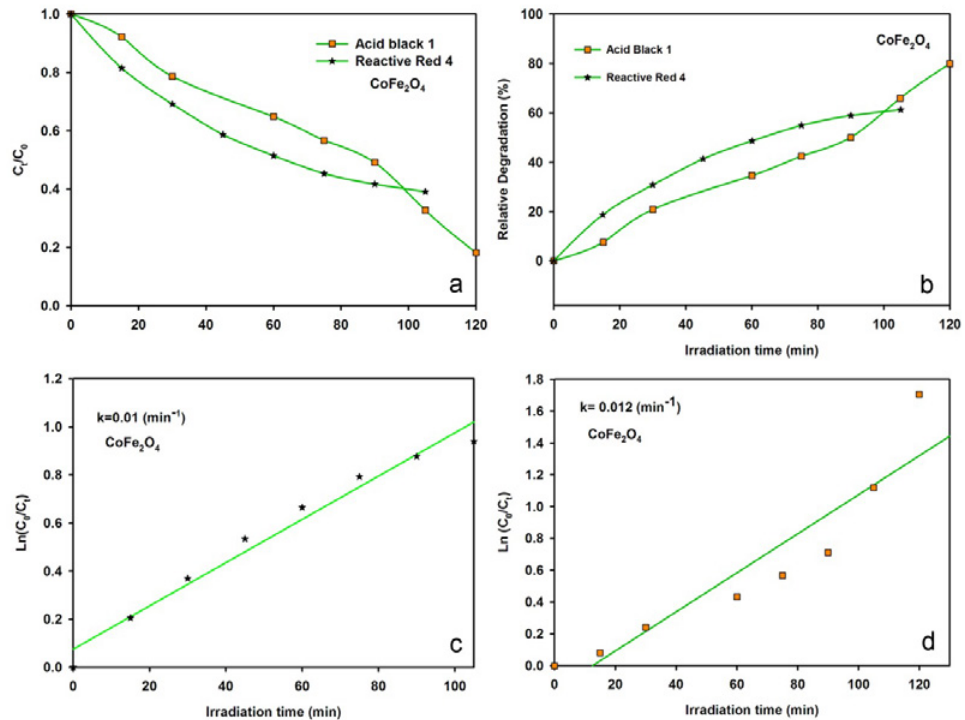
O (B & E), CoFe O (C & F) photocatalysts in 30000 and 60000 magnitude, 3 4 2 4